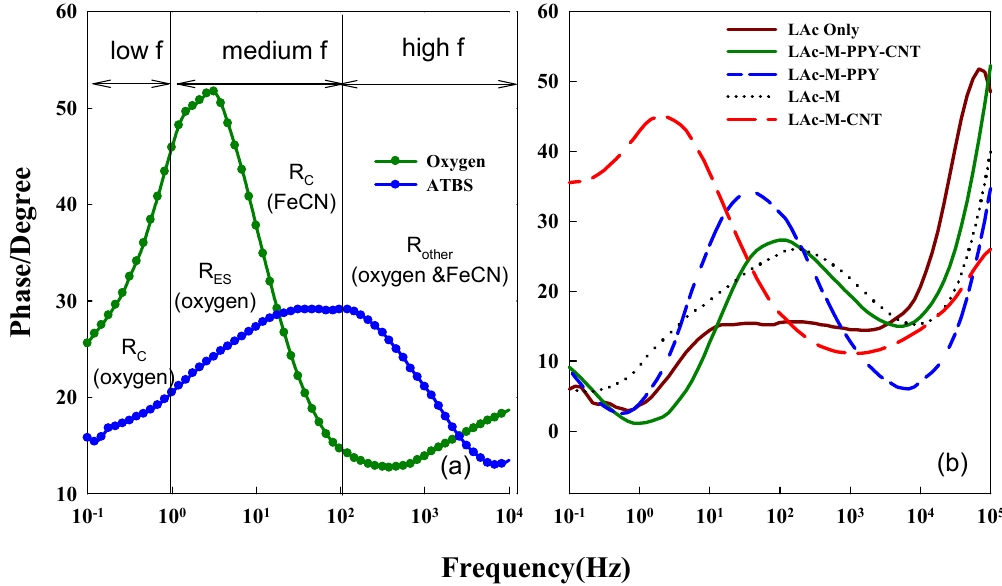
Figure 11. Bode plot of ( a ) biocathode with 2,2-azino-bis (3-ethylbenzothiazoline-6-sulphonic acid (ABTS) and oxygen-based EBFC; ( b ) Bode phase angle plot of LAc with different electrodes.